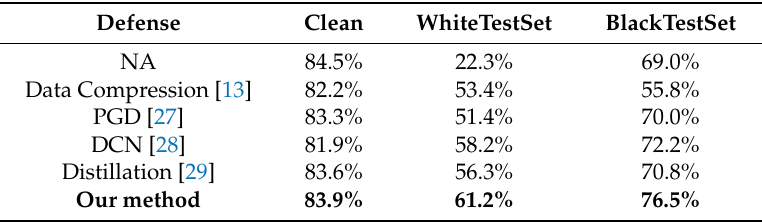
Table 3. The accuracy of model under different defending